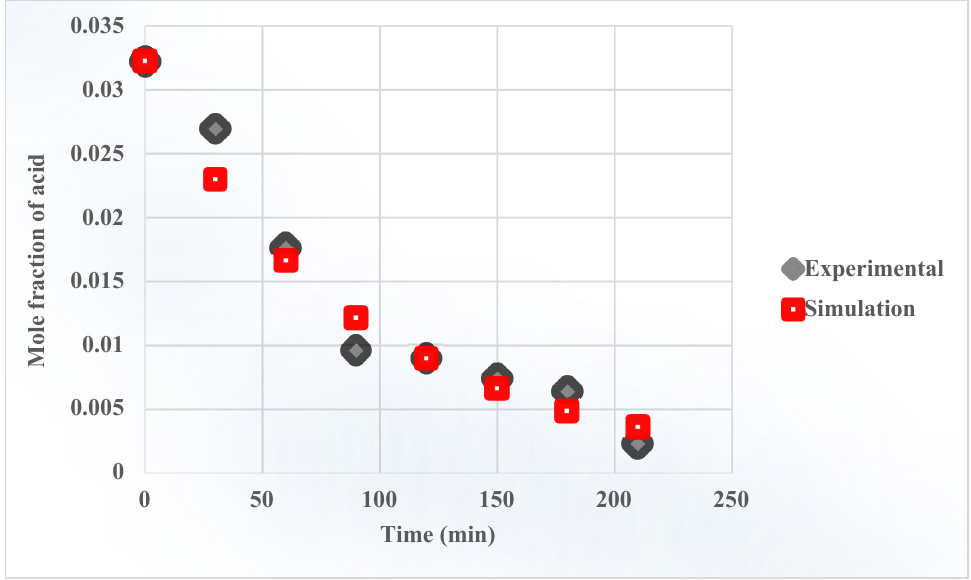
Figure 7. The batch reactor mole fraction vs time.